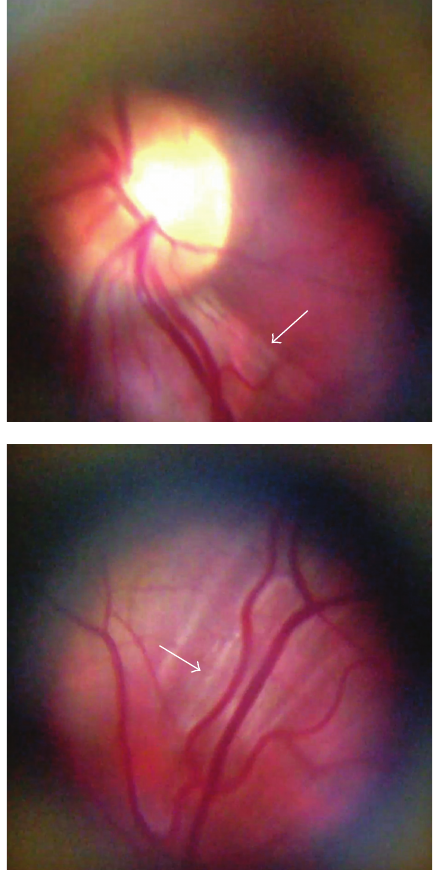
Figure 5: Cross-polarization-accentuated nerve-fiber layer defini- tion (white